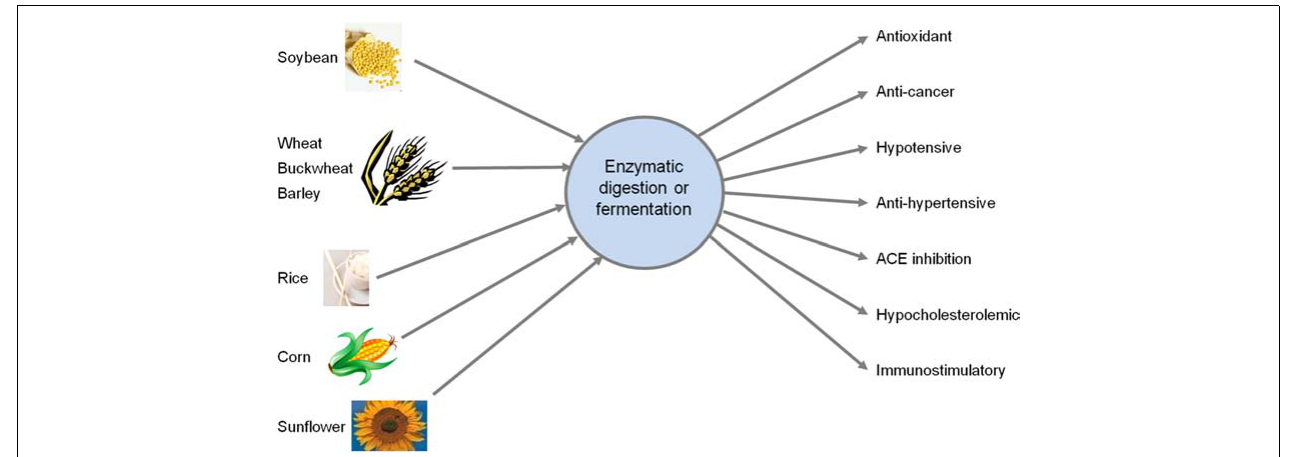
FIGURE 2 | Functions of plant-derived bioactive peptides released by enzymatic digestion or fermentation: again, the example of the plant world is chosen with soy, rice, cereals, and sunflower as sources. Through enzymatic digestion or fermentation, bioactive peptides can be